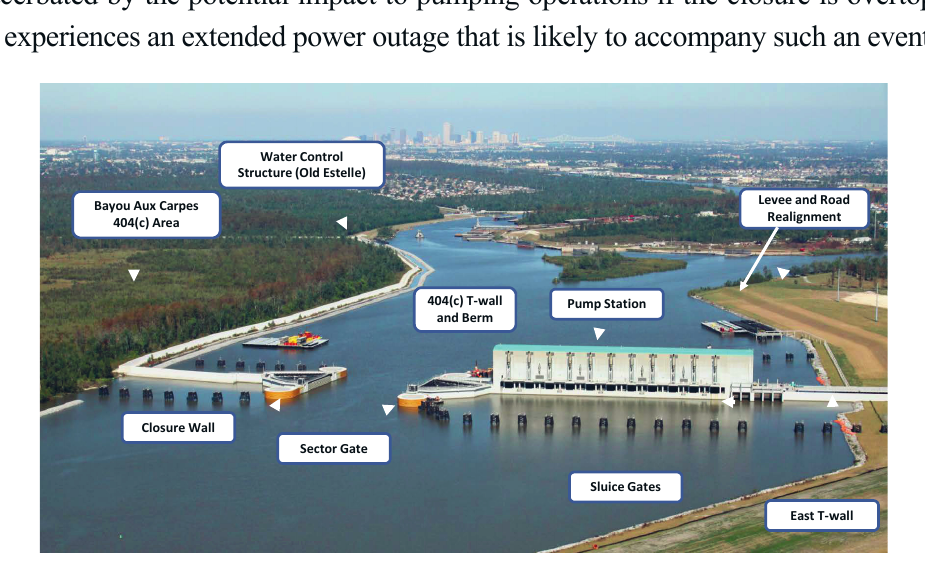
Figure 10. Image of the GIWW—West Closure Pump